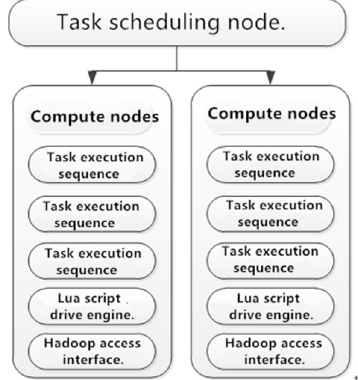
Figure 2. Calculation node of energy saving management